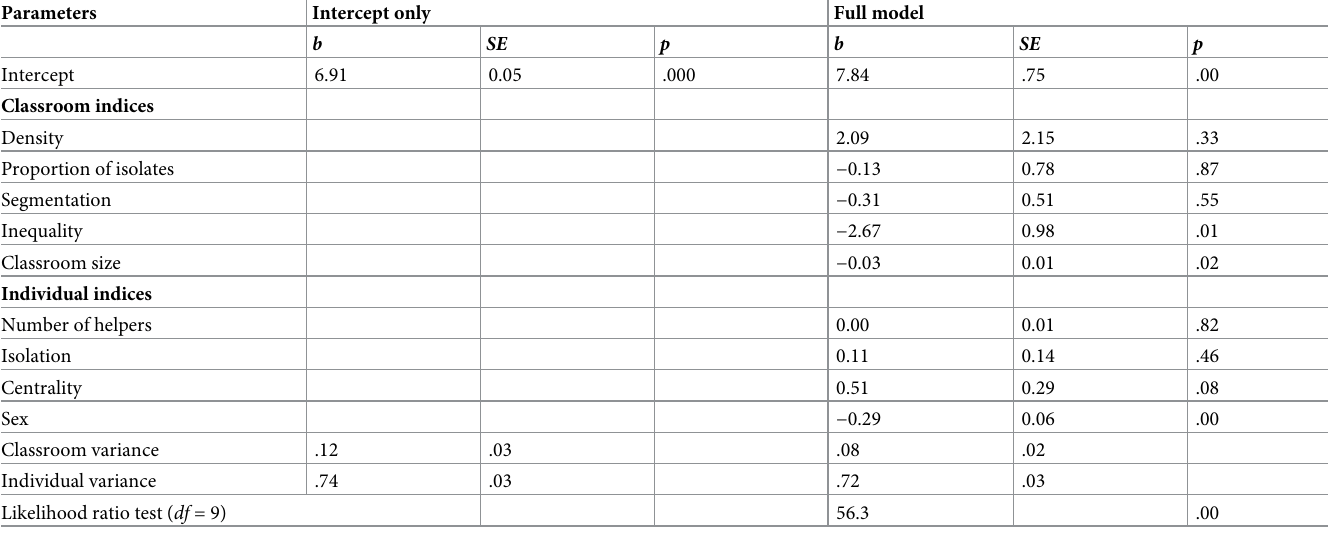
Table 2. Estimated multilevel coefficients for the associations of classroom and individual network indices with academic achievement (N = 54 classrooms; 1,056 students a